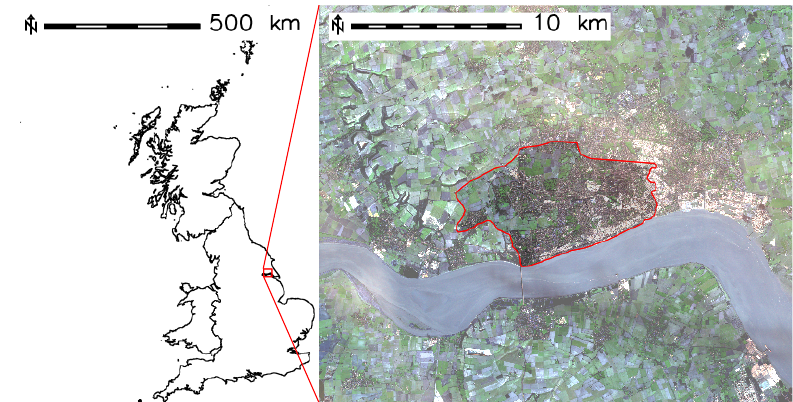
Figure 8. Location of the Hull study area (satellite imagery Copernicus Sentinel 2016).